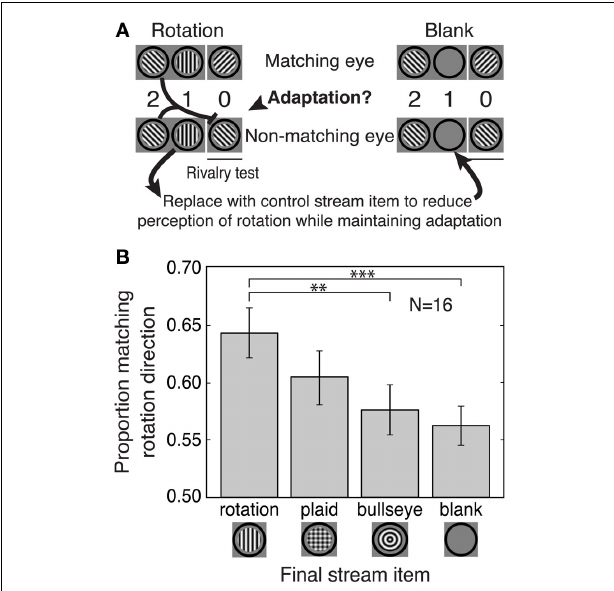
FIGURE 3 | Experiment 3: Separate contributions of prediction and adaptation to the matching effect. (A) Schematic of the stimuli. Left: An example rotation stream showing how adaptation to the second-to-last stream item could bias selection toward the matching stimulus. Right:To control for adaptation, the final stream item was replaced with one of three other stimuli (plaid, bullseye, or blank; the blank condition is shown here). These alternative final stream items reduced the perception of rotation while maintaining any orientation-specific adaptation to the second-to-last stream item. (B) The size of the rotation matching effect decreased with increasing disruption of rotation perception.The bullseye and blank conditions quantify the effects of adaptation alone, as no perception of rotation was possible for these conditions.The matching effect for the rotation condition was significantly larger than that for the bullseye or blank condition, indicating an effect of predictive context that cannot be accounted for by adaptation. Error bars are SEM. ∗∗ p < 0.01; ∗∗∗ p <